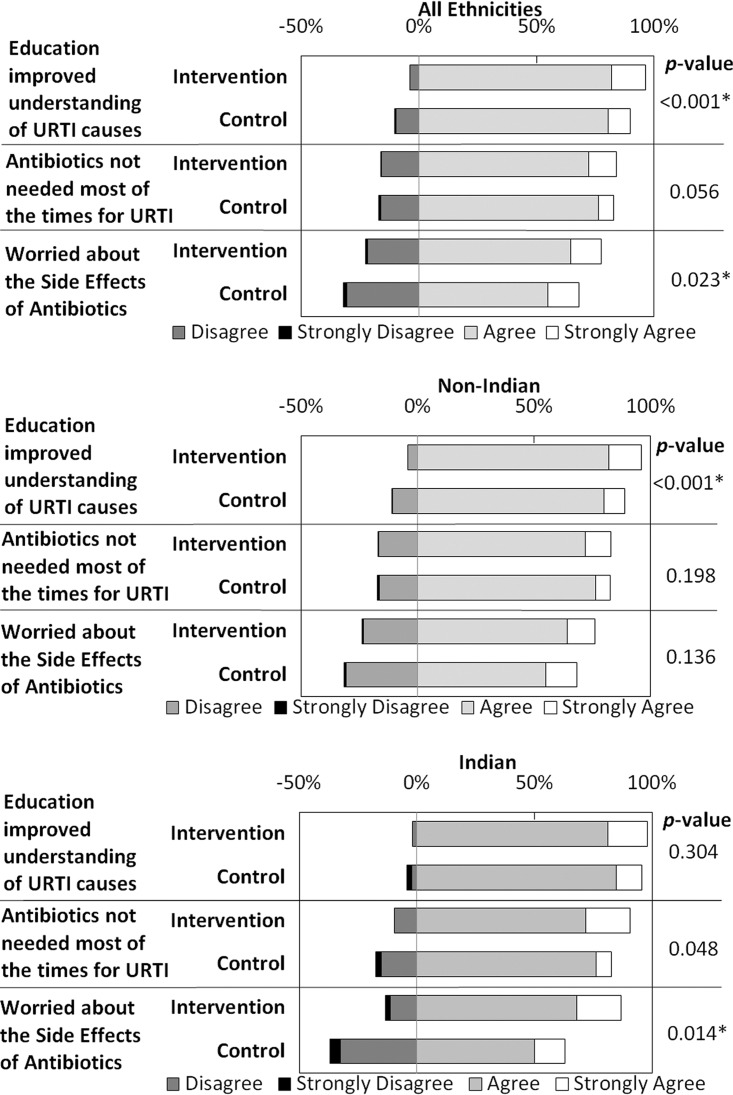
Effects of intervention on patients' views about URTI and antibiotic use. Black, dark gray, light gray, and white sections of the bars represent strongly disagree, disagree, agree, and strongly agree, respectively, with P values from Mann-Whitney U tests given for the comparison of responses between the control and intervention arms.